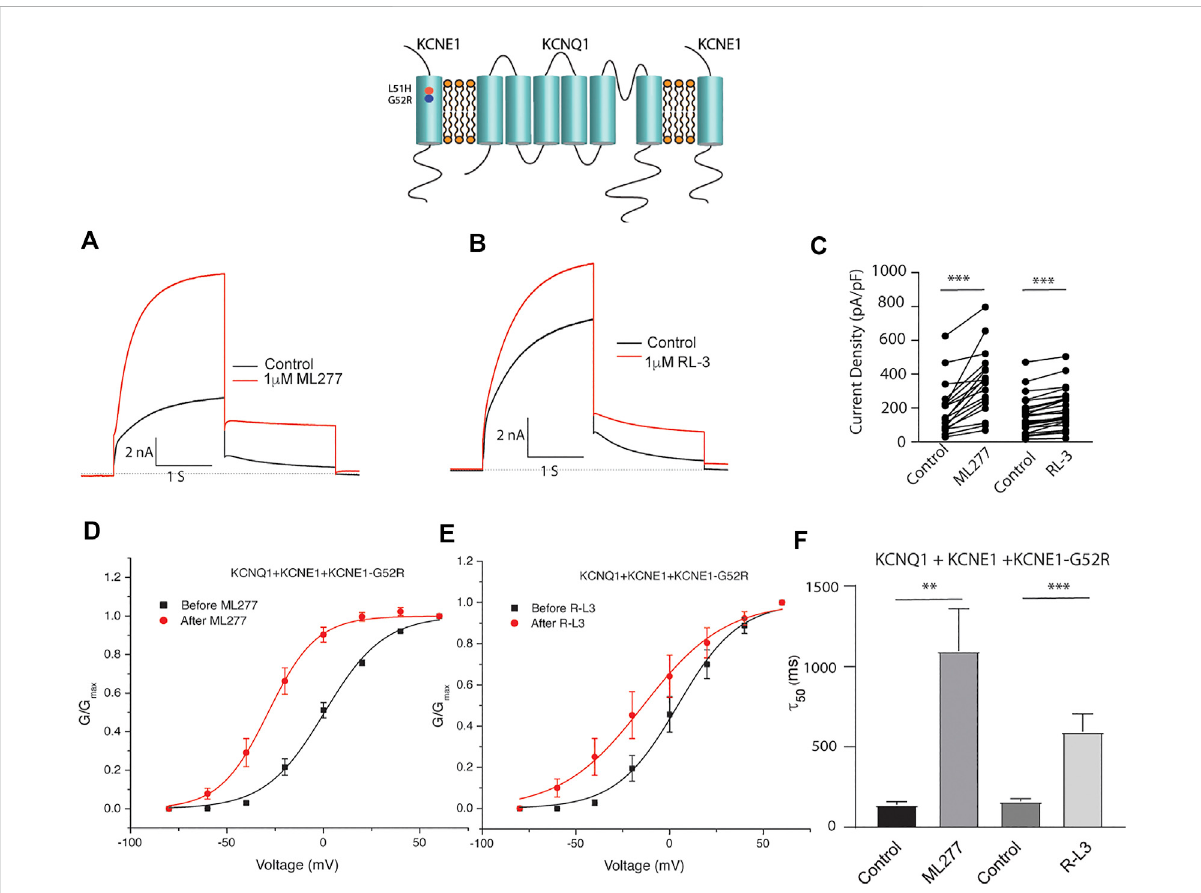
FIGURE 7 Heterozygous KCNE1-G52R mutant channel activity is potentiated by KCNQ1 agonists. Cells were transfected with KCNQ1/KCNE1/KCNE1- G52R and exposed to 1 μ M ML277 (A) and 1 μ M R-L3 (B) . Transfections were carried out with KCNQ1 and KCNE1 WT and KCNE1 mutant ratios of 1: 0.5:0.5 as described in thetext. Currents recorded at+60 mV are shown before (black traces) and after (red traces) exposureto drugs. (C) . Summary data for current density measured at +60 mV at 2 s in which straight lines connect peak current in the absence and presence of drugs in individual cells. (D) . Normalized KCNQ1/KCNE1/KCNE1-G52R conductance/voltage curves measured in the absence (black) and presence of 1 μ M ML277(red). (E) .NormalizedKCNQ1/KCNE1/KCNE1-G52Rconductance/voltagecurvesmeasuredintheabsence(black)andpresenceof1 μ MRL-3 (red). (F) . Summaryof slow deactivationtime tail constant ( τ 50) measured at − 40 mV inthe absence and presence of 1 μ Meach drug. ML277: n = 14; R-L3: n =